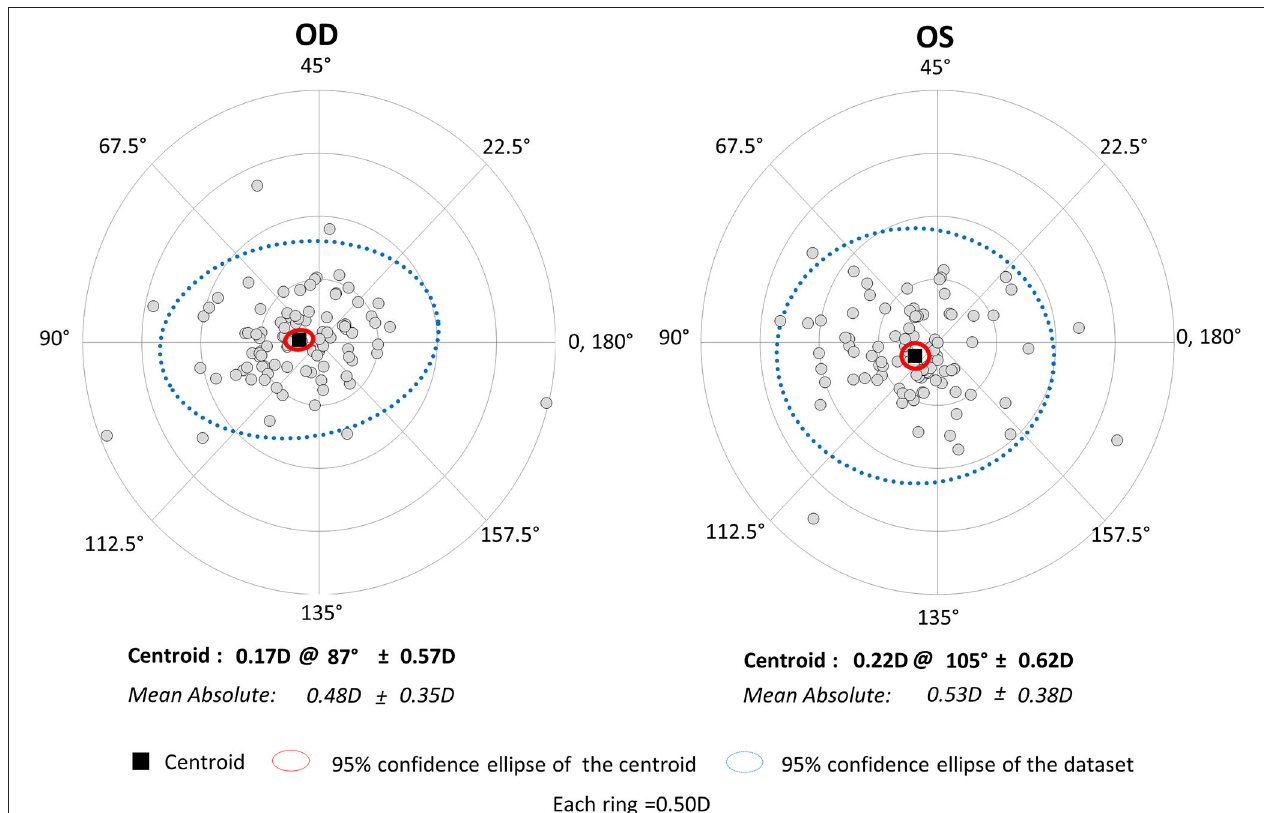
FIGURE 3 | Graph showing the double angle plots of the individual surgically induced astigmatism using unilateral